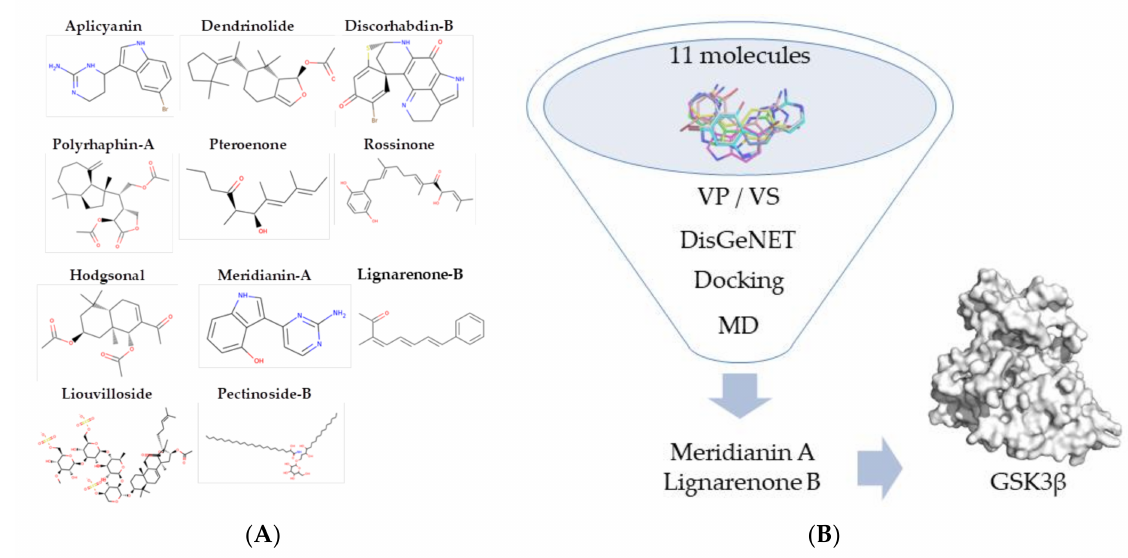
Figure 1. ( A ) List of previously isolated marine molecules. Structures of the eleven marine molecules selected for the initial study. ( B ) Workflow process. Graphical representation of the workflow process to disentangle Meridianin A and Lignarenone B as promising therapeutic molecules capable to inhibit Glycogen Synthase Kinase 3 (GSK3) β [34].